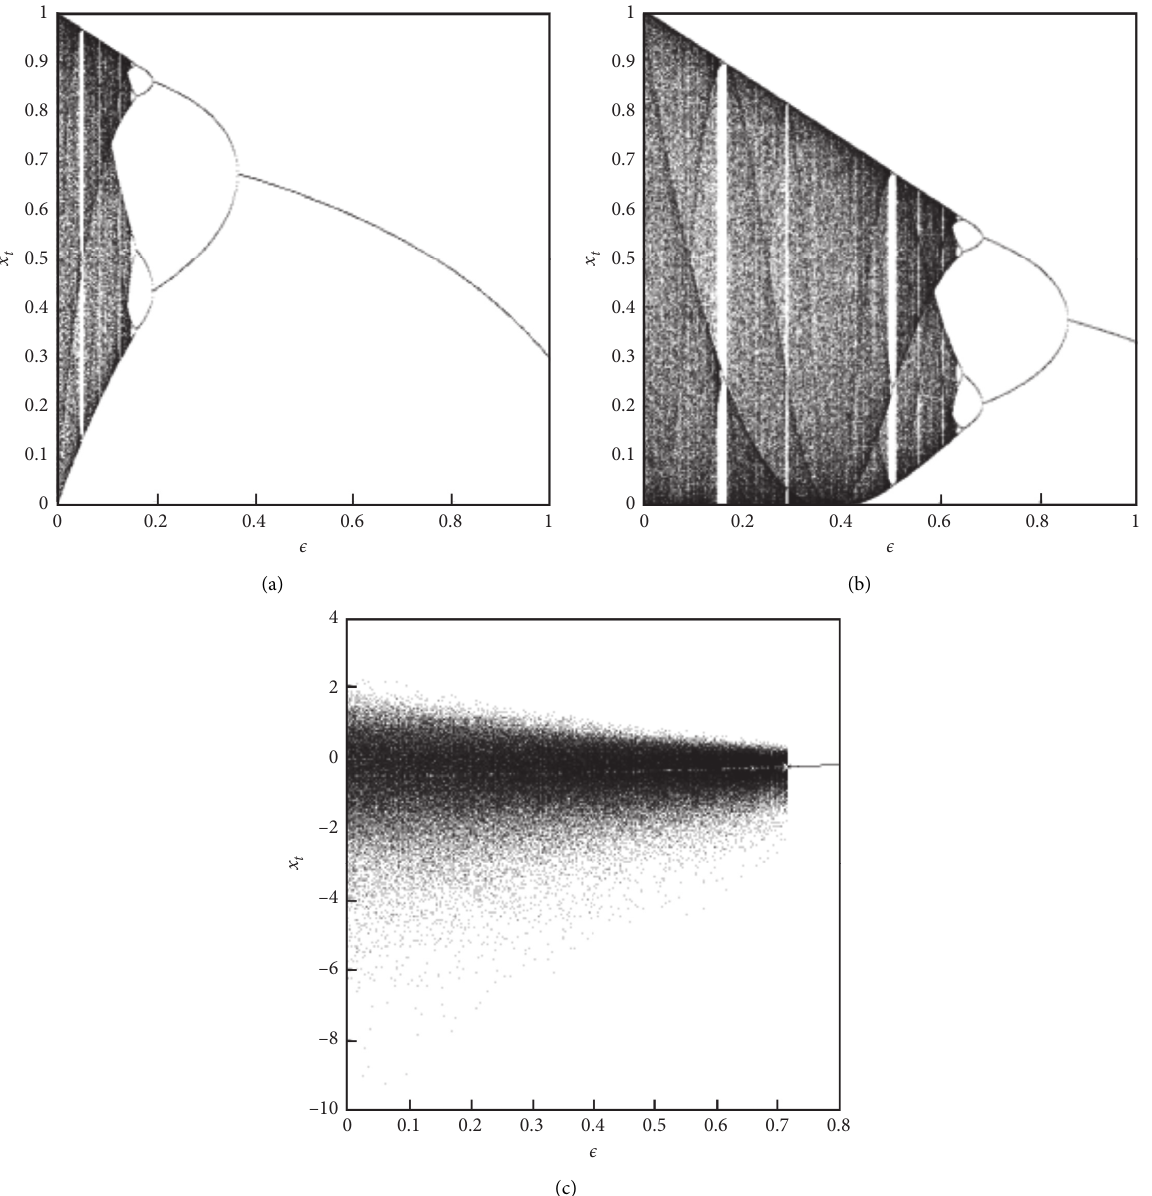
Figure 8: Bifurcation diagrams of the driven map x (a) f ( x ) � ( 1 − b ( 1 − x ) x /1 − b 1/4 ) with b � 0 . 5. (b) f ( x ) � sin 2 ( r arcsin (